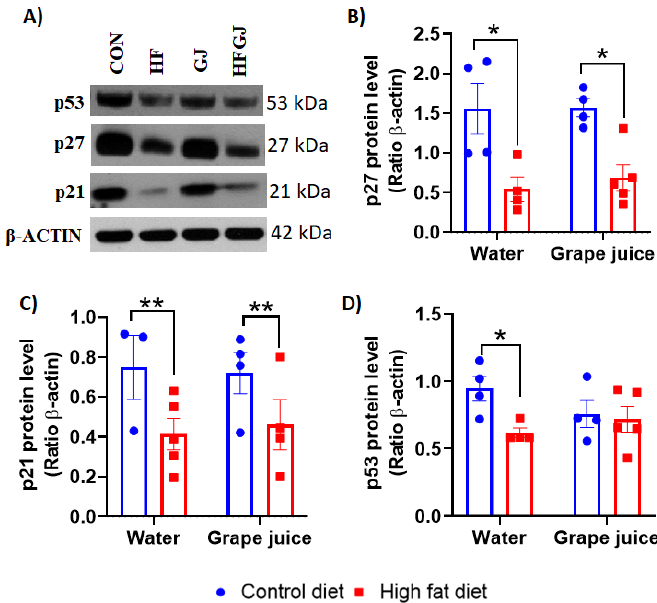
Figure 3. (A) Representative Western blots and quantitated data of (B) p27, (C) p21 and (D) p53